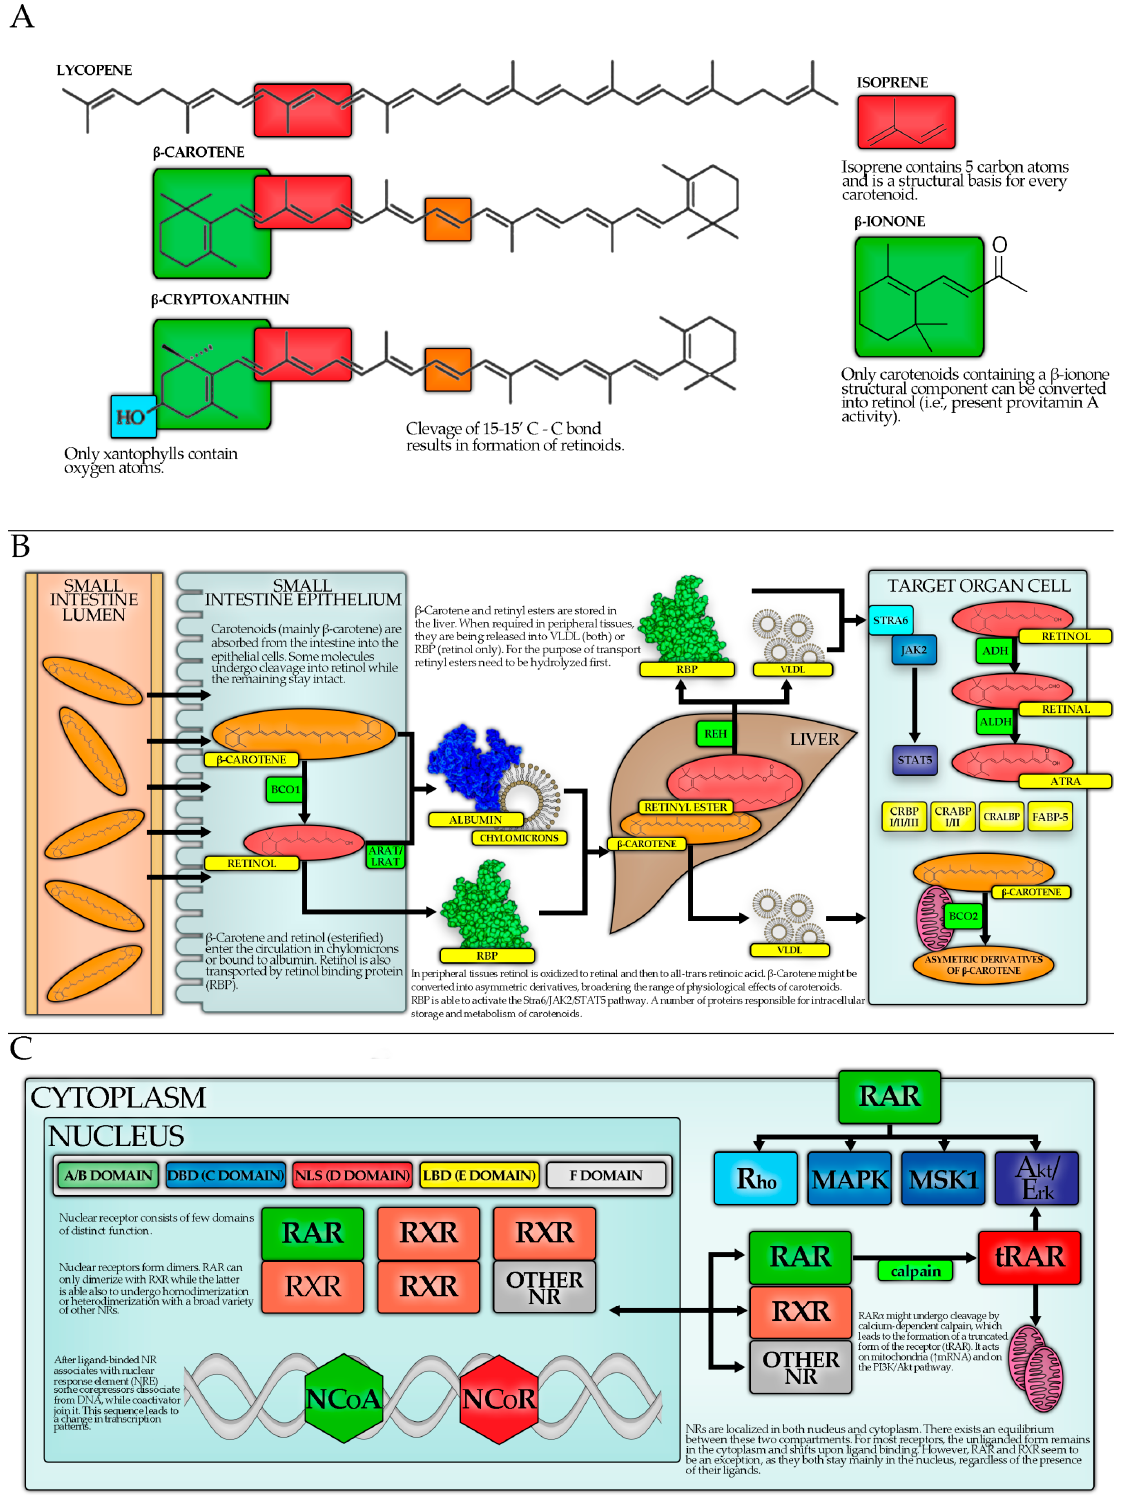
Figure 1. Main metabolic pathway of carotenoids. ( A ) The structure of carotenoids. ( B ) The process of absorption and metabolism of carotenoids. ( C ) The main intracellular targets of